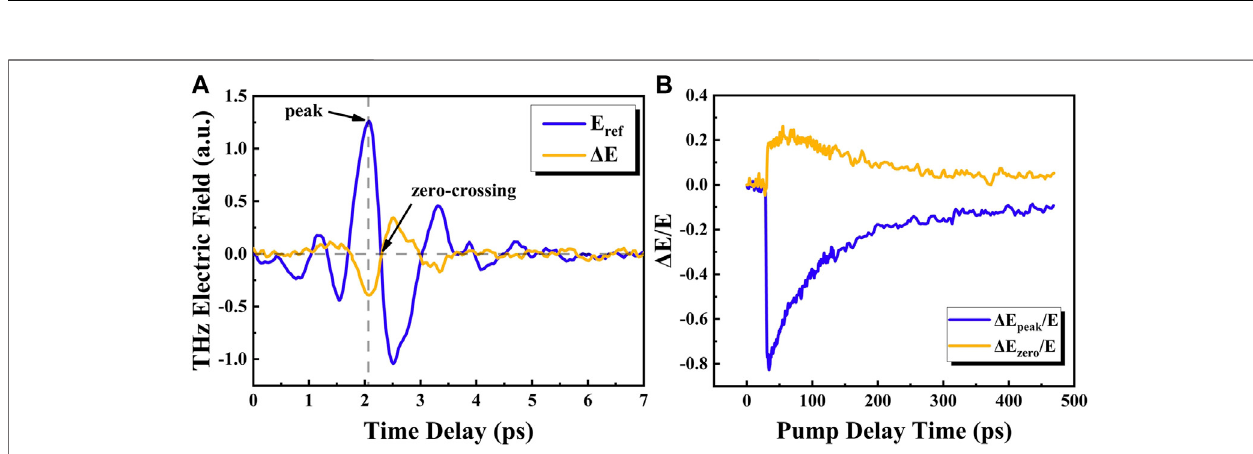
FIGURE 1 | (A) Raman spectrum for layered MoS 2 crystal with 532 nm laser excitation. (B) Simpli fi ed energy band diagram based on fi rst-principles calculation. The two arrows represent the direct and indirect transition from the valence band maximum to the conduction band minimum.